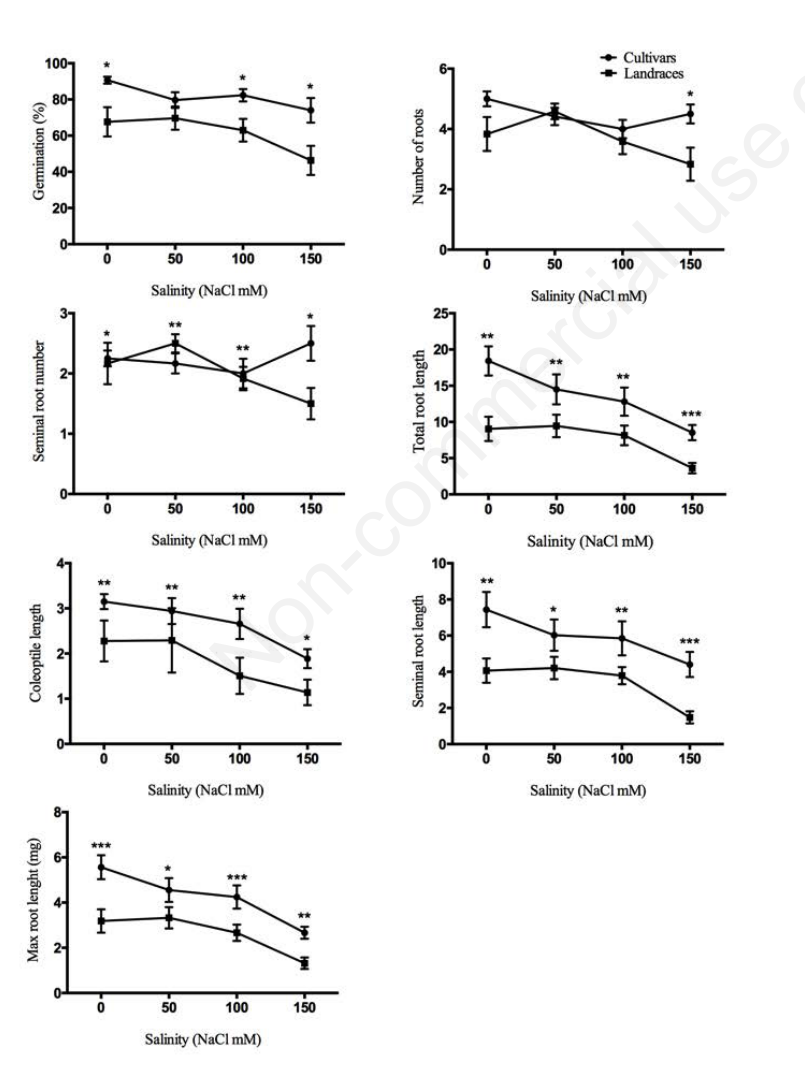
Figure 2. Genotypic variation in germination percentage and root architectural traits in three landraces of durum wheat at salinities of 100 and 150 mM NaCl. Bars represent the means ± standard error of four individuals per genotype. Different letters indicate signif- icant differences between genotypes at P ≤